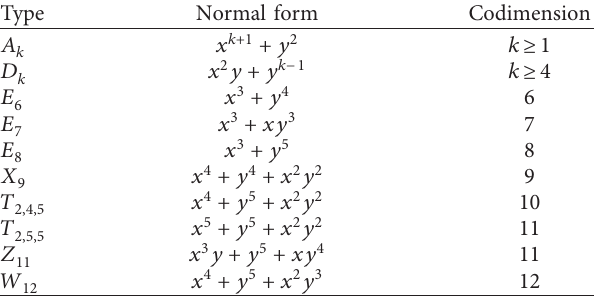
Table 1: Lipschitz Simple Function Germs of corank 1 and 2.